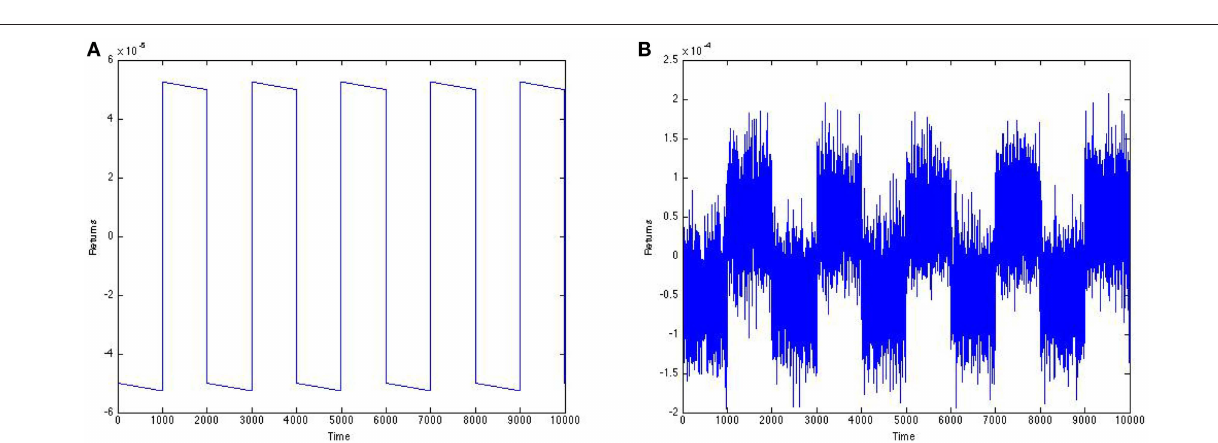
FIGURE 12 | (A) Returns corresponding to the price signal in Figure 11A . (B) Returns corresponding to the price signal in Figure 11B